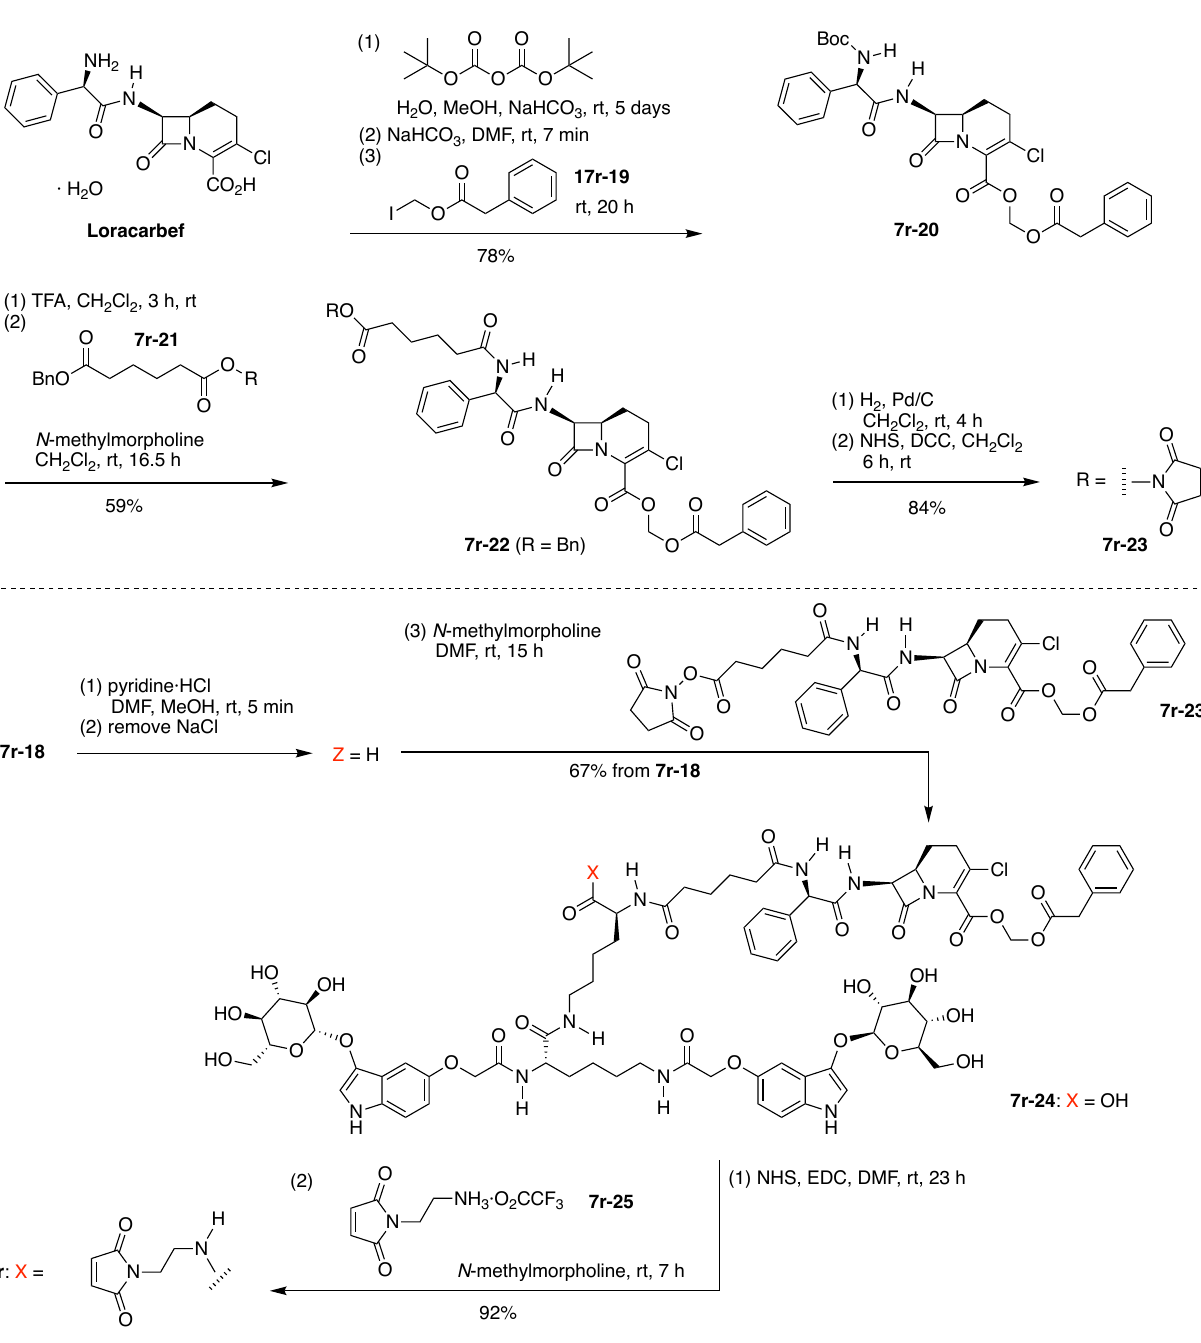
Figure 20. Completion of the synthesis of 7r , with composition A 2 B 2 CD and architecture [3] 2 [2] 2 [1] 4 . Bis(indoxyl-glucoside) 7r-18 was acidified to convert the carboxylate to the free acid, which upon reaction with Loracarbef derivative 7r-23 gave 7r-24 . DCC-mediated activation of the latter with N -hydroxysuccinimide followed by reaction with N -(2-aminoethyl)maleimide phenylacetoxymethyl-protected Loracarbef unit, and a maleimido unit for attachment to a (Figure 20). The final structure contains 7 amide bonds: 6 as part of the peptide scaffold, and 1 as part of the Loracarbef structure. Loracarbef together with the mutant β -lactamase (not shown here) provides a new type of